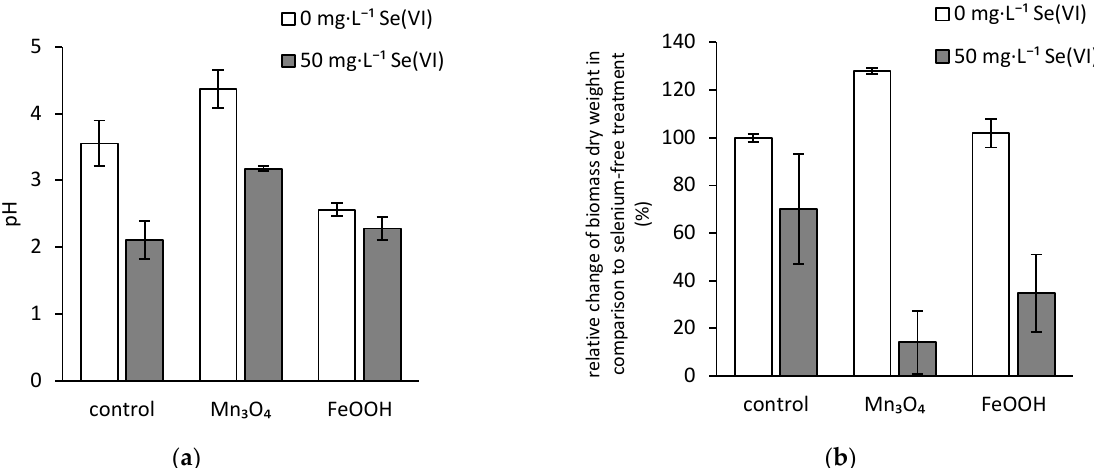
Figure 1. Effects of selenium on ( a ) pH and ( b ) biomass synthesis during the three-week static incubation of hausmannite (Mn 3 O 4 ) or amorphous ferric oxyhydroxides (FeOOH) in the presence of filamentous fungus Aspergillus niger (control represents the treatment without any solid inorganic phases).